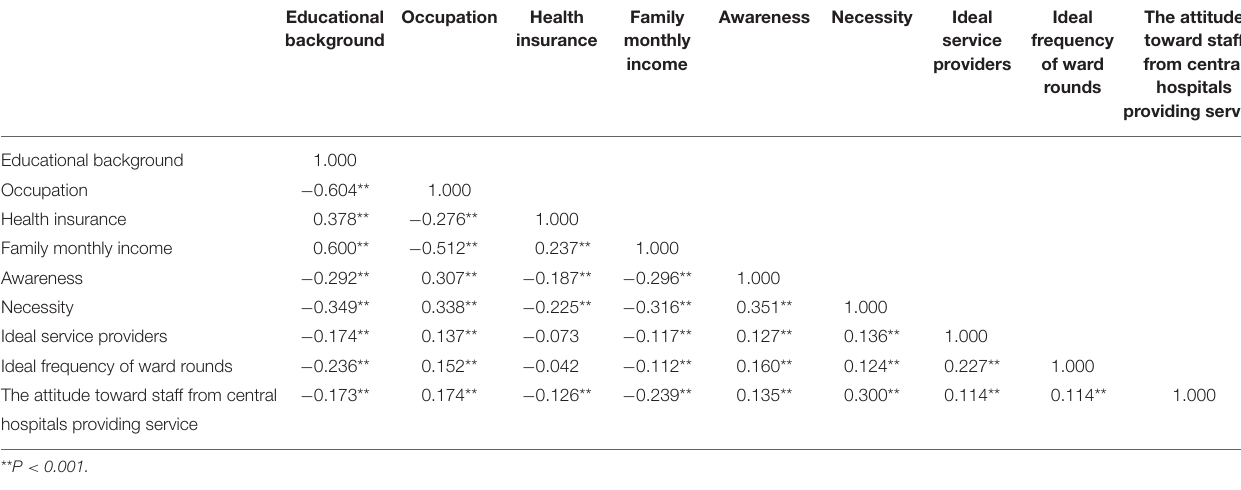
TABLE 3 | Correlation between the independent variables.